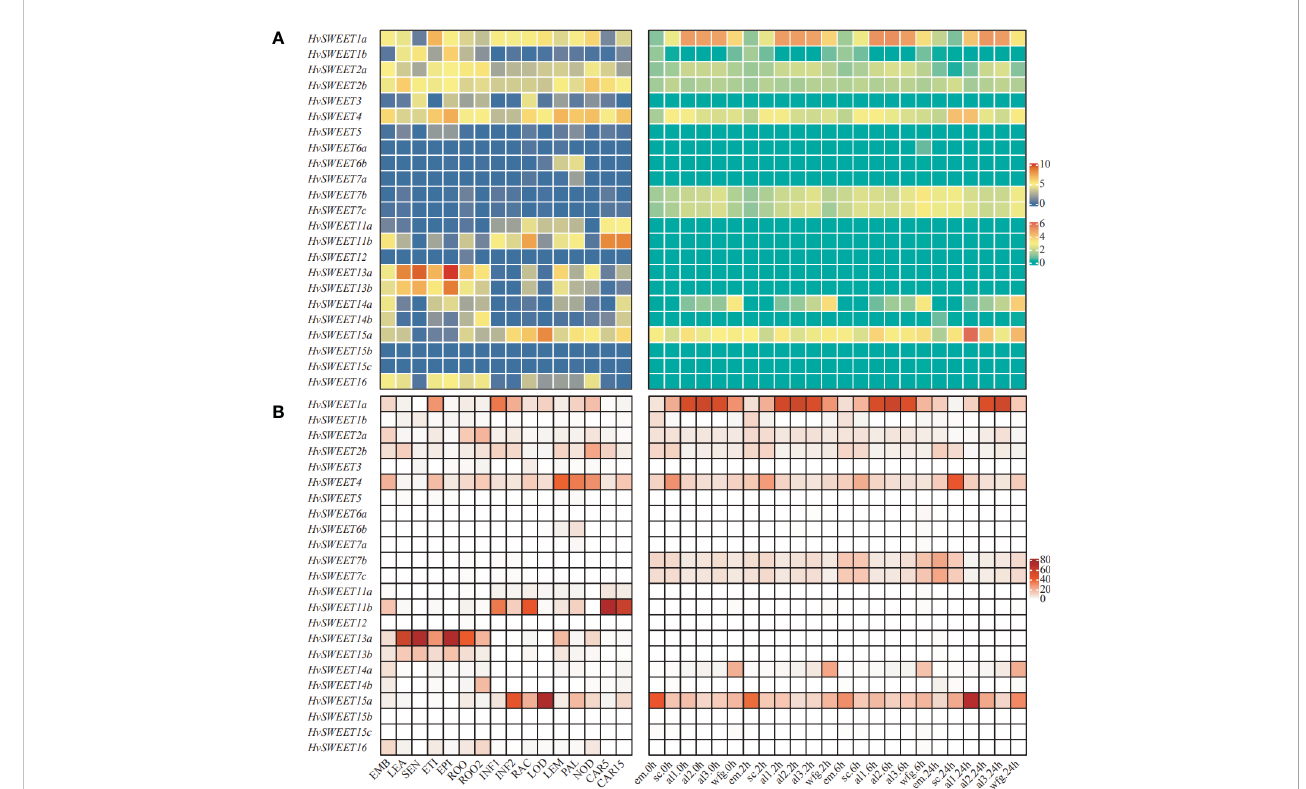
FIGURE 4 Expression pro fi les (A) and expression proportions of HvSWEET genes in that of the whole gene family (B) in the published different developmental tissues (Mascher et al., 2017) (left panel) and seed tissues during germination (Betts et al., 2017) (right panel). The TPM values of each gene, normalized by TMM method, are used for (B) and the transformation values by log 2 (TPM+1) are used for (A) . Left panel: EMB, 4 days after planting (dap) embryo; LEA, 17 dap leaf; SEN, 56 dap senescing leaf; ETI, 10 dap etiolated leaf grown in dark; EPI, 28 dap epidermal strips; ROO, 17 dap root; ROO2, 28 dap root; INF1, 30 dap in fl orescences; INF2, 50 dap in fl orescences; RAC, 35 dap in fl orescence rachis; LOD, 42 dap lodicule; LEM, 42 dap lemma; PAL, 42 dap palea; NOD, the third stem internode (42 dap); CAR5, 5 days post-anthesis (dpa) caryopsis; CAR15, 15 dpa caryopsis. Right panel: em, embryo; sc, scutellum; al1, one third of aleurone proximal to the embryo; al2, the central third of aleurone; al3, one third of aleurone distal to embryo; wfg; whole fi xed grain; 0h, 2h, 6h and 24h represent the corresponding time after seed